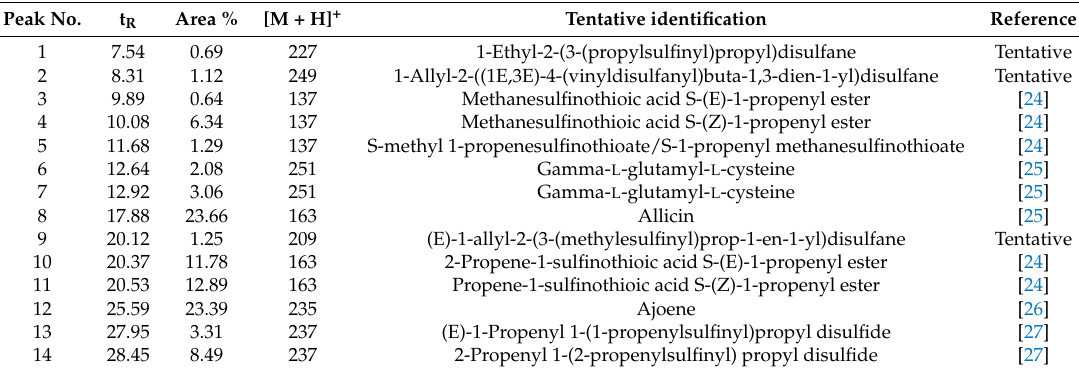
Table 2. Identification of sulfur-containing compounds in Allium cepa extract by LC-ESI-MS/MS. Peak No. Both garlic and onion extract inhibited the growth of trypanosomes and leishmanias.